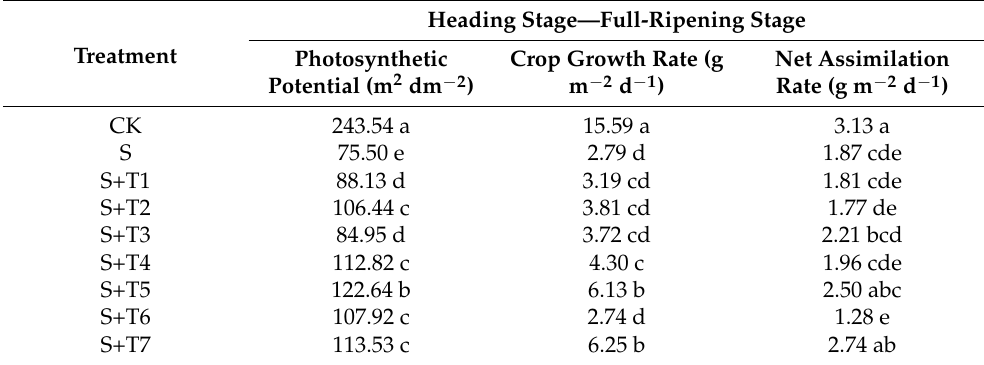
Table 6. The photosynthetic potential, crop growth rate, and net assimilation rate of